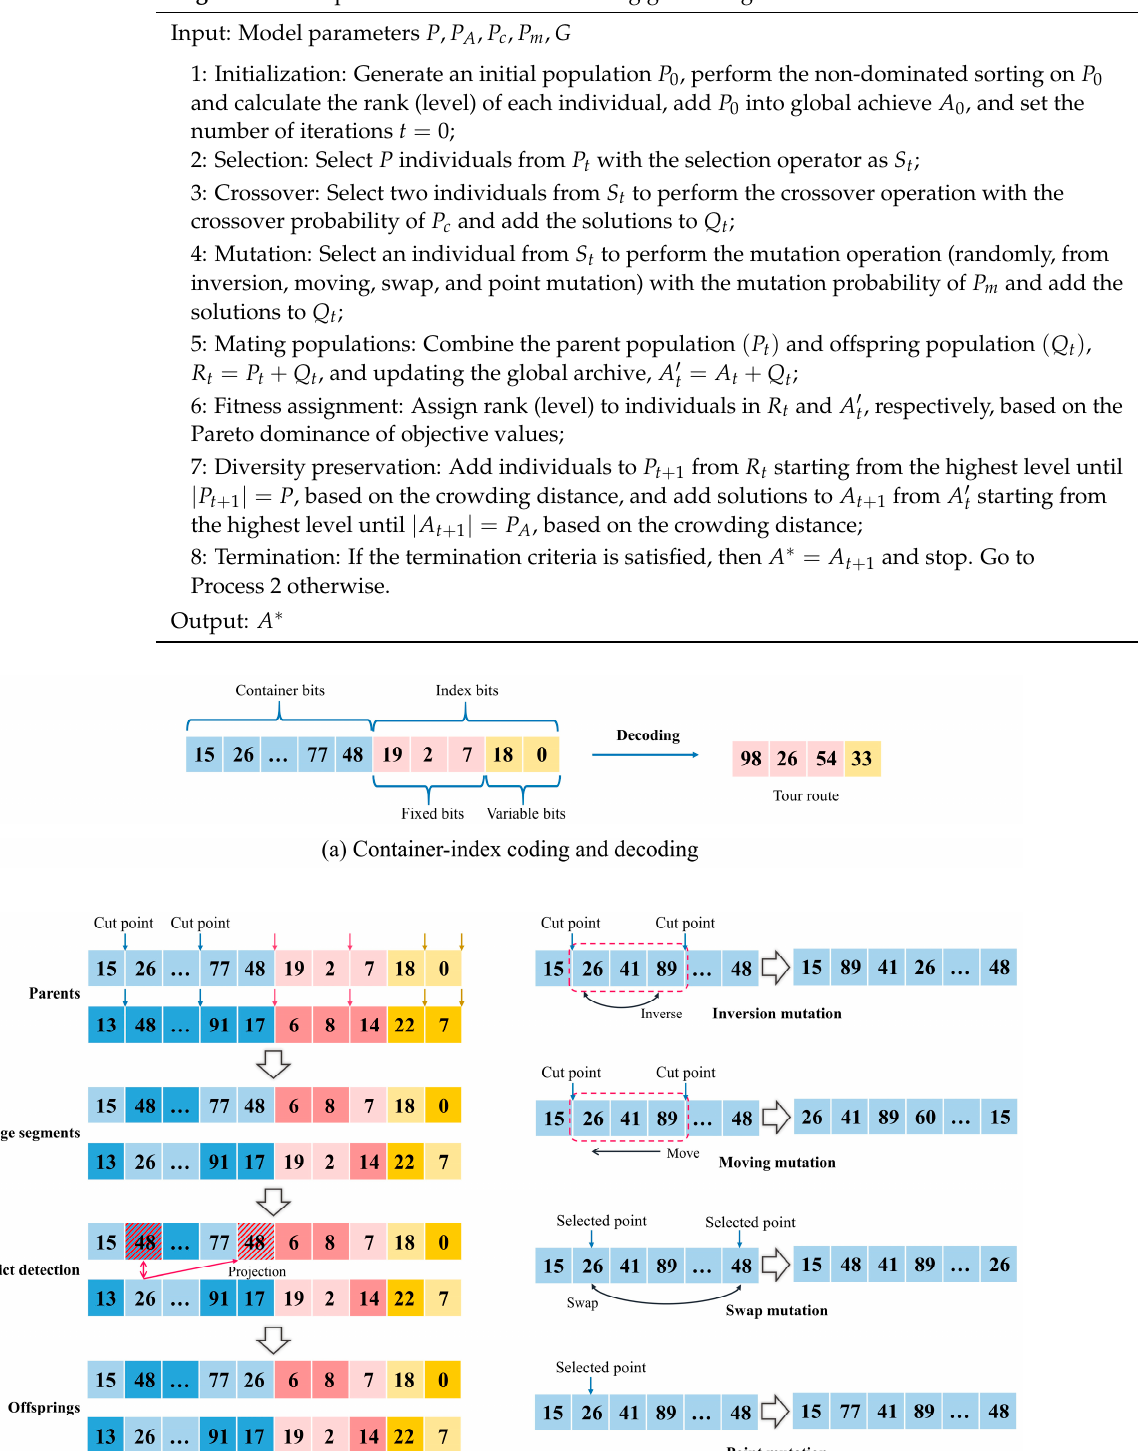
Algorithm 1: Improved non-dominated sorting genetic algorithm II